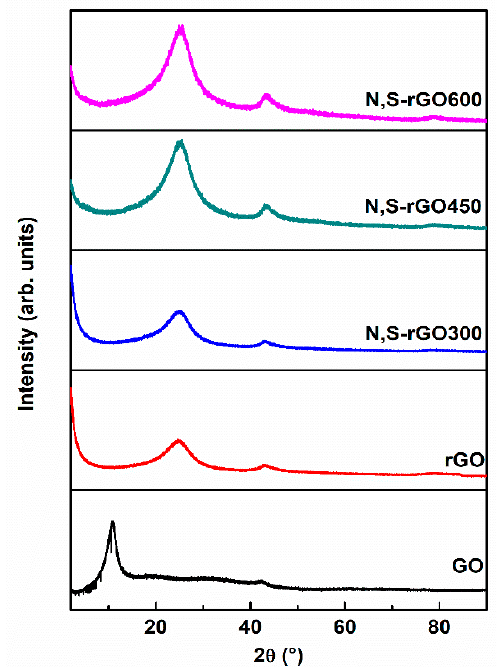
Figure 2. XRD patterns for precursors of